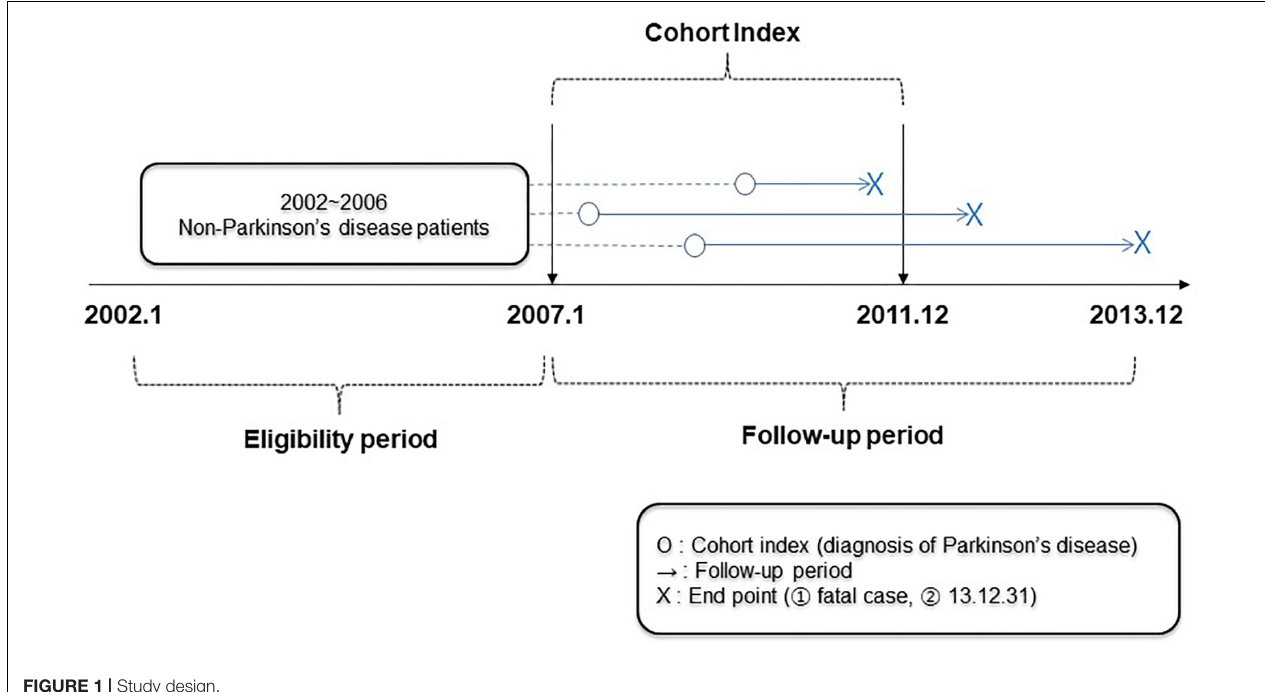
FIGURE 1 | Study design.